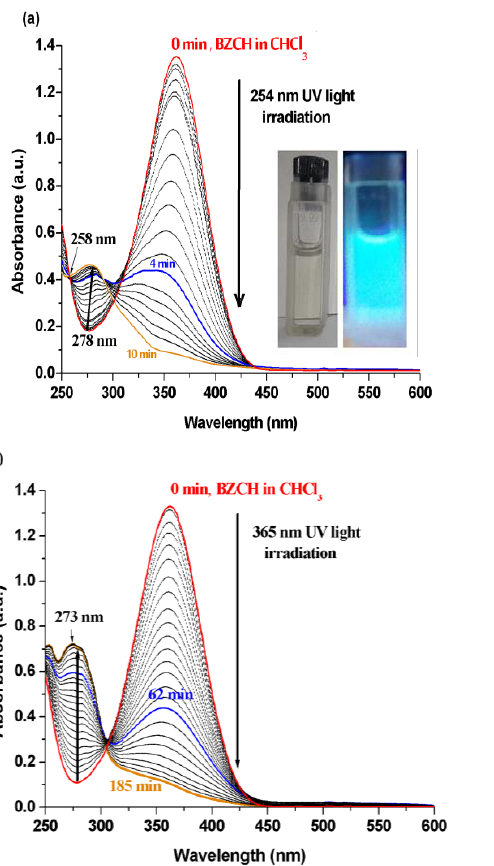
Figure 6. UV-Vis absorption spectral variations of BZCH during irradiation with 254 nm ( a , b ) and 365 nm ( c , d ) UV light at various intervals of time, in CHCl3 ( a , c ) and DMSO ( b , d ) solutions. Inset: Photograph of BZCH under daylight and UV light.